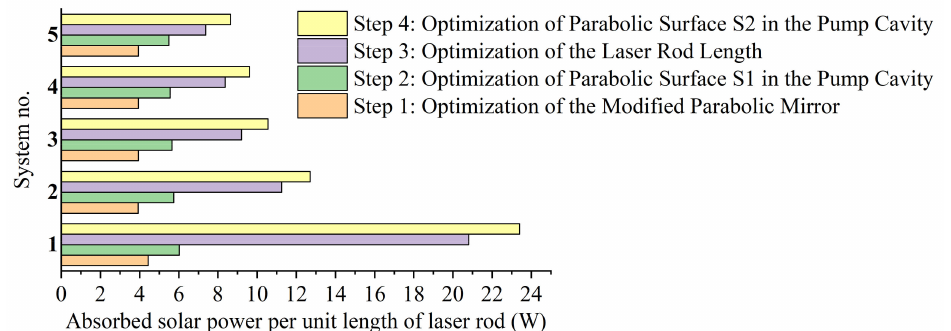
Figure 9. Influence of the optimization processes on the absorbed solar power per unit length laser of